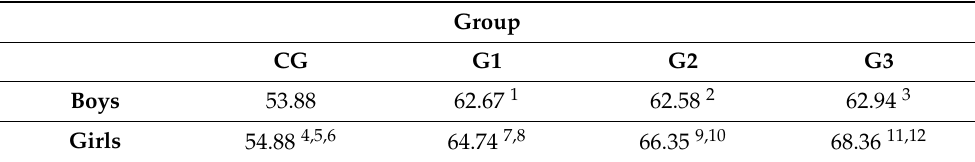
Table 2. Two-way ANOVA results for the overall BOT score within and between groups of different years of experience and